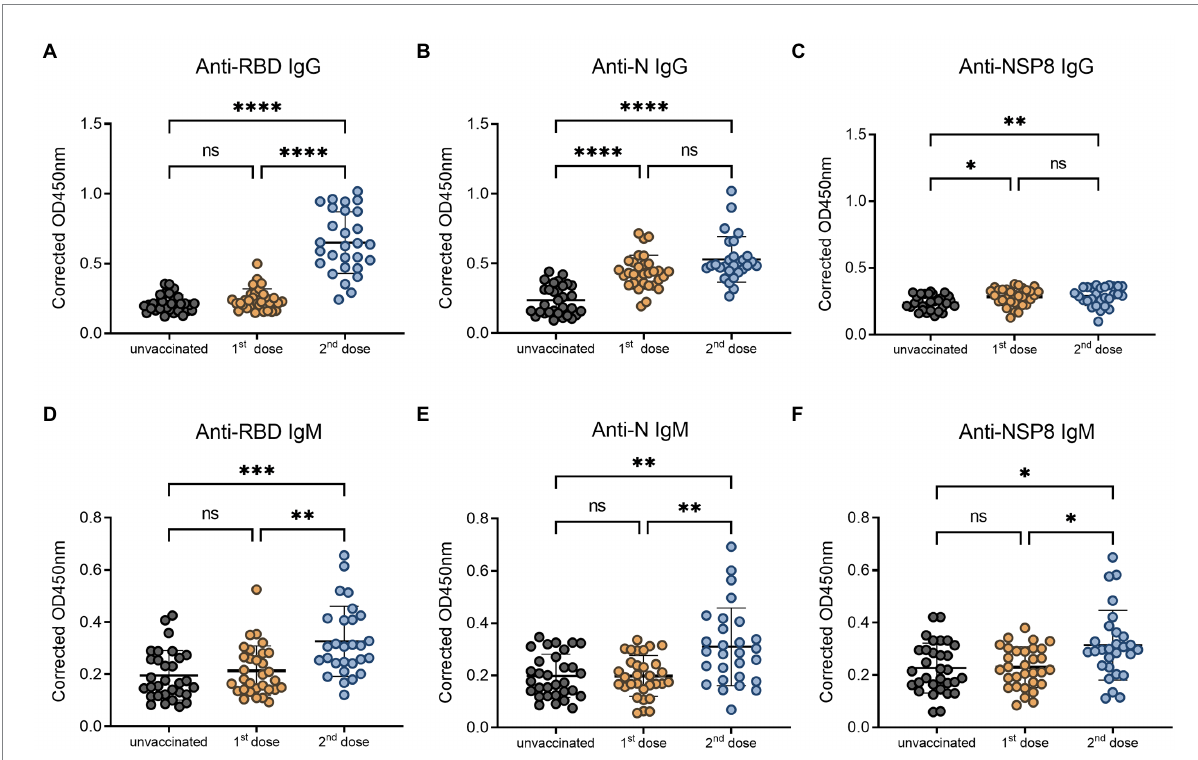
FIGURE 2 SARS-CoV-2 specific antibody responses after different doses of BBIBP-CorV. (A–C) IgG responses to RBD protein (A) , N protein (B) , and NSP8 protein (C) . (D–F) IgM responses to RBD protein (D) , N protein (E) , NSP8 protein (F) . Serum samples were from the 1 st dose vaccination group ( n = 31), and 10–30 days post the 2 nd dose vaccination group ( n = 28) with unvaccinated group ( n = 31) as control. Value of p was calculated by one- way analysis of variance (ANOVA) or Kolmogorov–Smirnov